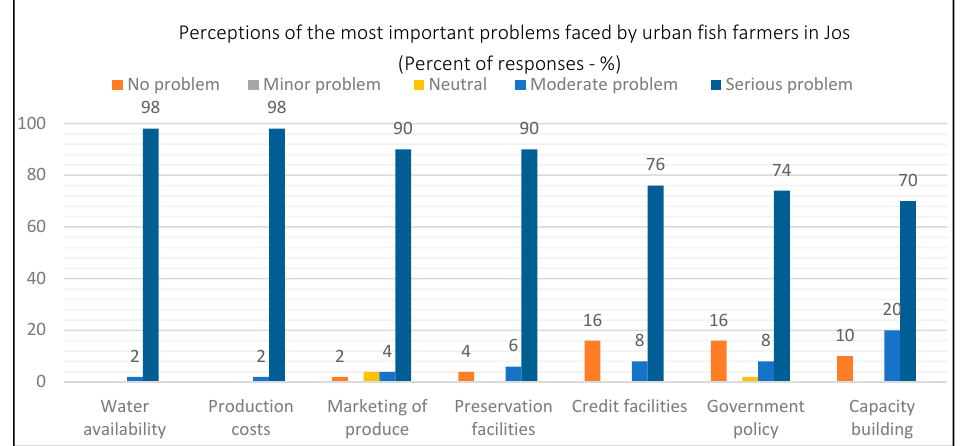
Figure 6. Perceptions of the most important problems faced by urban fish farmers in Jos.